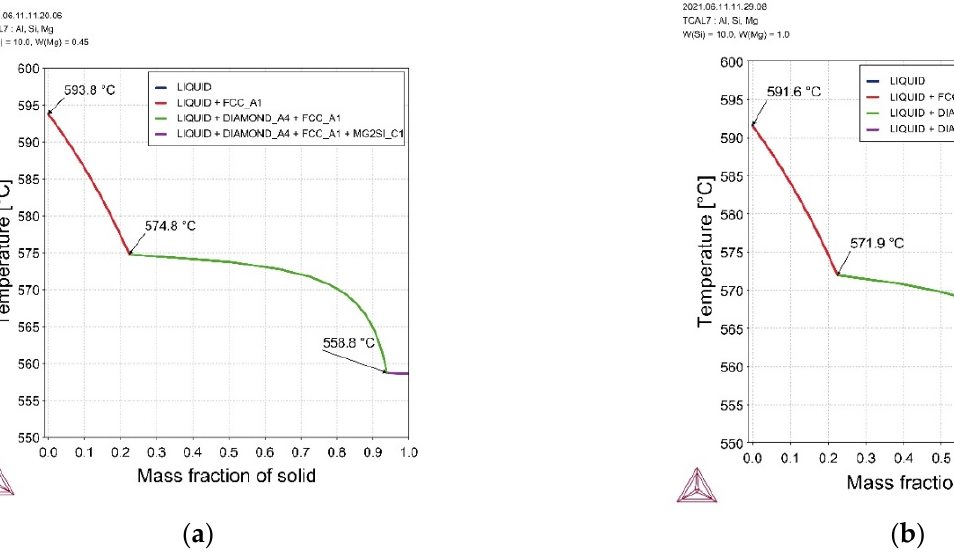
Figure 2. Scheil diagrams showing the solidification sequences related to the ( a ) Al-10 wt.% Si-0.45 wt.% Mg and ( b ) Al-10 wt.% Si-1 wt.% Mg alloys.